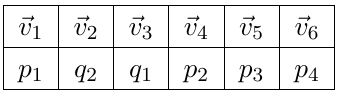
Table 3 . Relation between toric data (4.120) and perfect matchings for the SPP singularity [32]. shown that the large N limit of the free energy, F , obtained from the exact localized S 3 partition function on S 3 , takes the form (4.48), with the Sasakian volume Vol( Y ) given 7 in (A.14). Moreover the R-charges of the (cid:12)elds in the quiver may be expressed in terms of the geometric R-charges (cid:1) 3 d , de(cid:12)ned using the volumes of supersymmetric (cid:12)ve-dimensional a toric submanifolds T , through the relation a